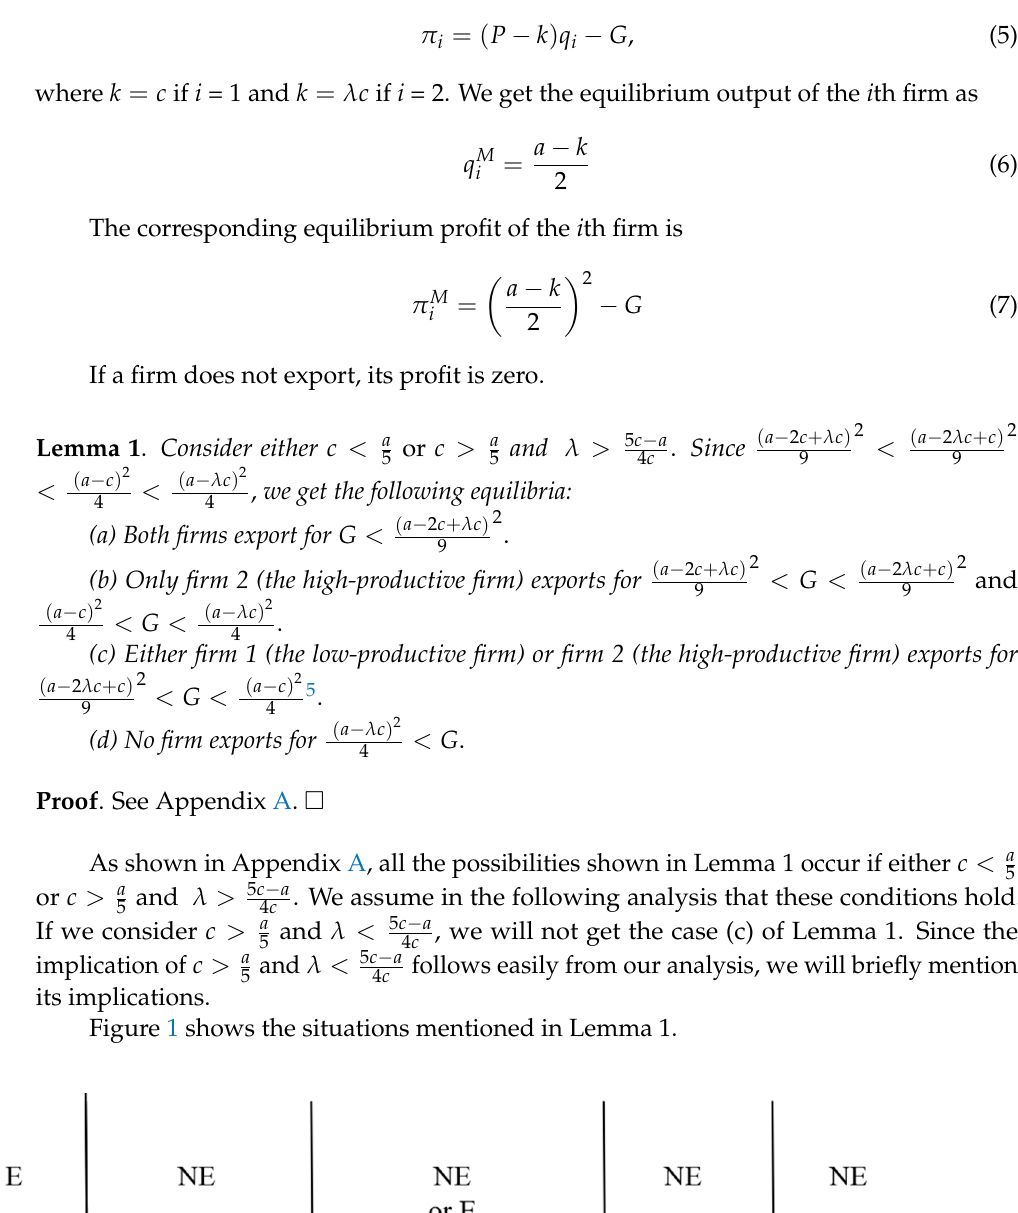
or c > a and λ > 5 c − a 5 5 4 c